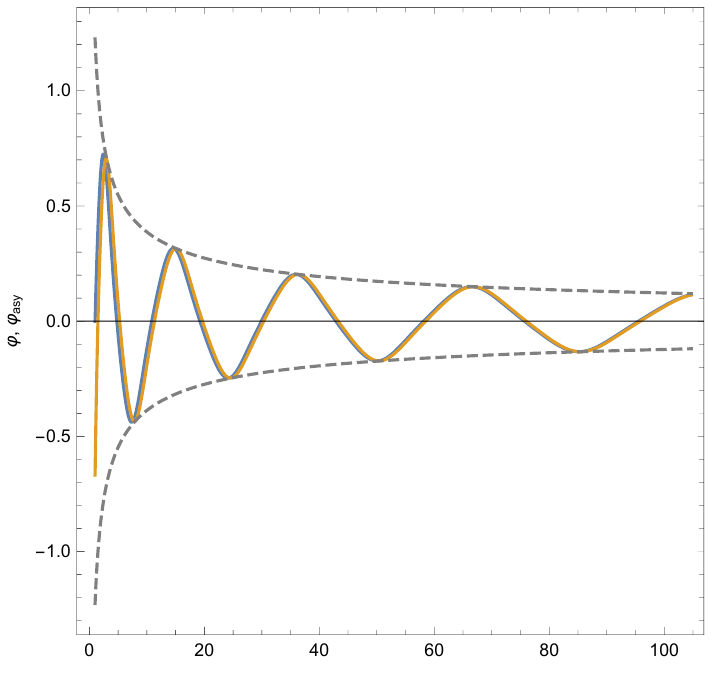
Figure 3. Numerical integration (blue line) with initial conditions ϕ ( 1 ) = 0, ϕ (cid:48) ( 1 ) = 1 and leading term of the asymptotic expansion (brown line) for the differential Equation (44) corresponding to the quartic potential. The dashed lines are the envelopes ± ( 3/ ( 2 τ )) 1/2 that set the scale for the generalised asymptotic solution (45).